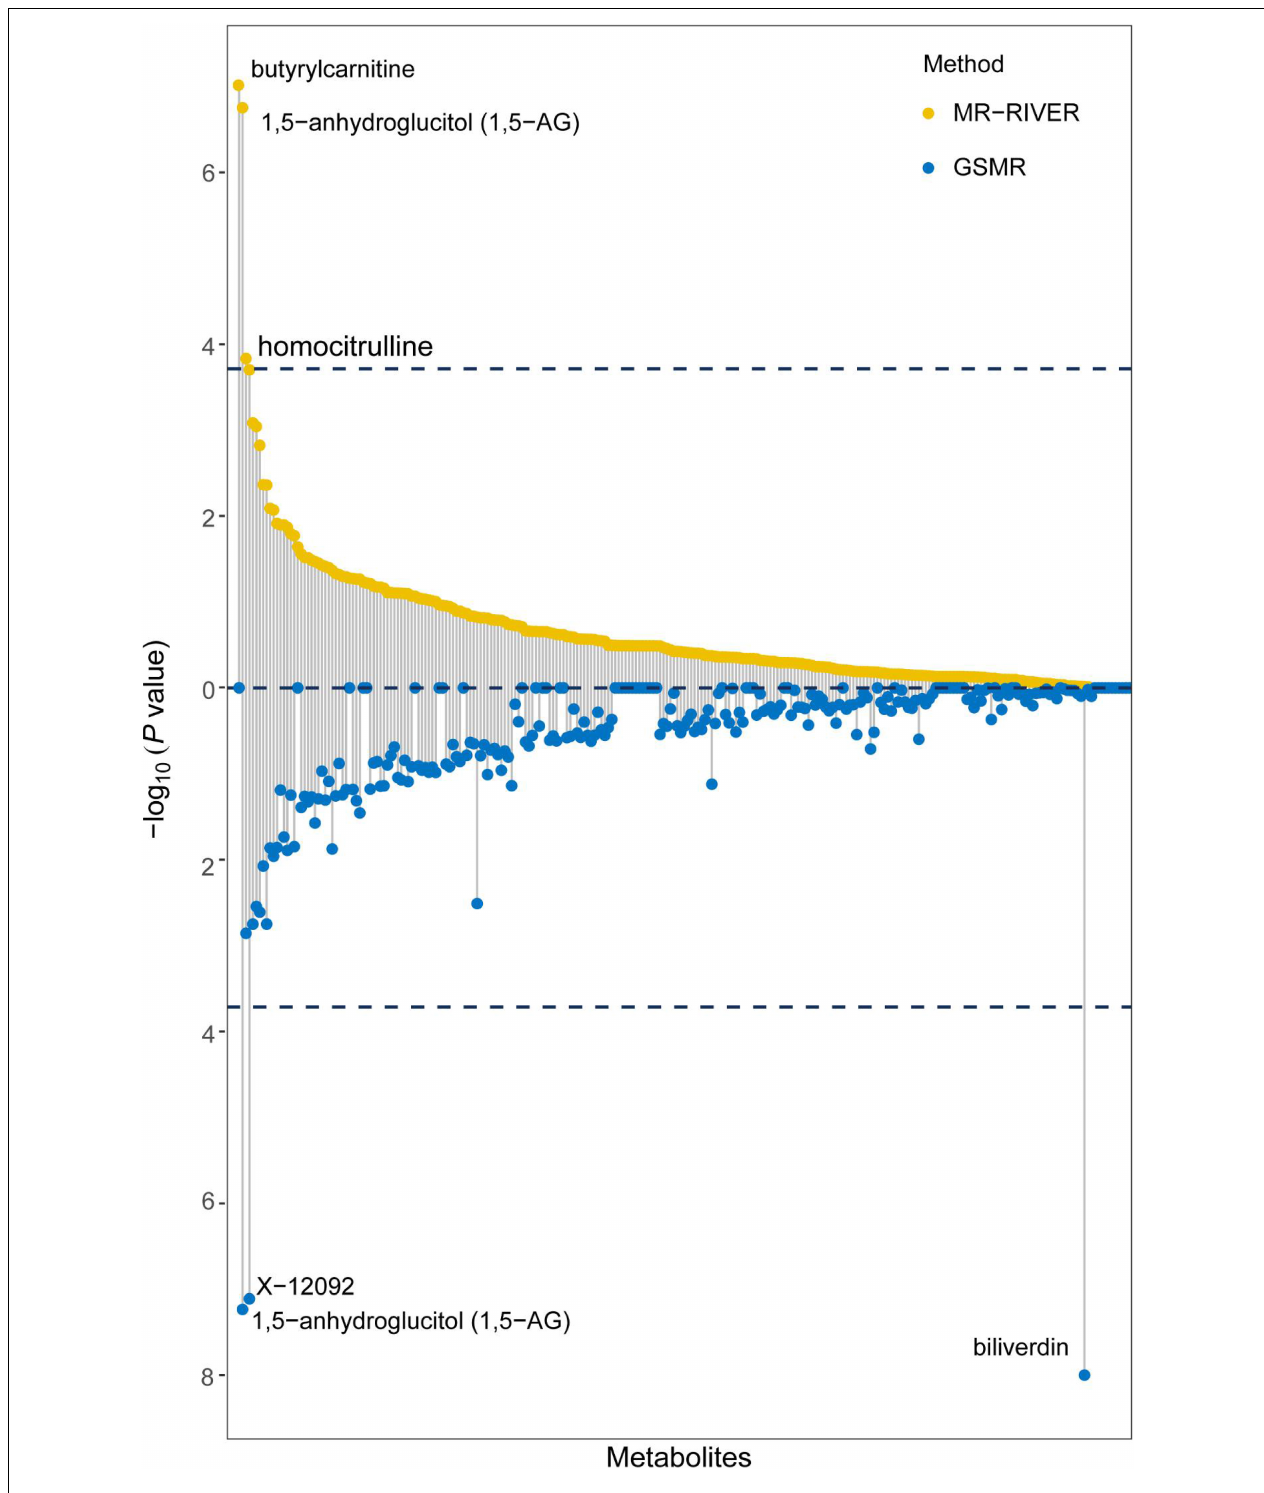
FIGURE 6 | MR-RIVER and GSMR analysis for causal association between metabolites and educational attainment. Relationship between individual metabolites with –log 10 ( P -value) of the association. Upper yellow values represent MR-RIVER results, and lower blue values represent GSMR results. Associated metabolites are annotated.